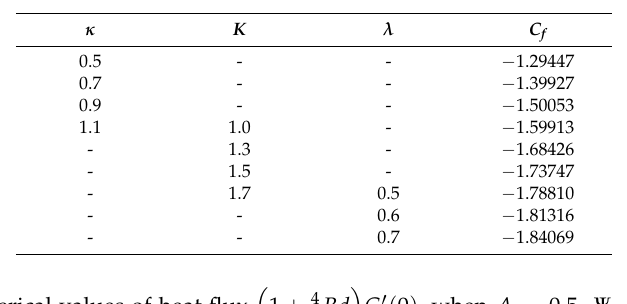
Table 1. The numerical values of skin fraction ( 1 + K ) F (cid:48)(cid:48) ( 0 ) − K time instant τ = π /2.